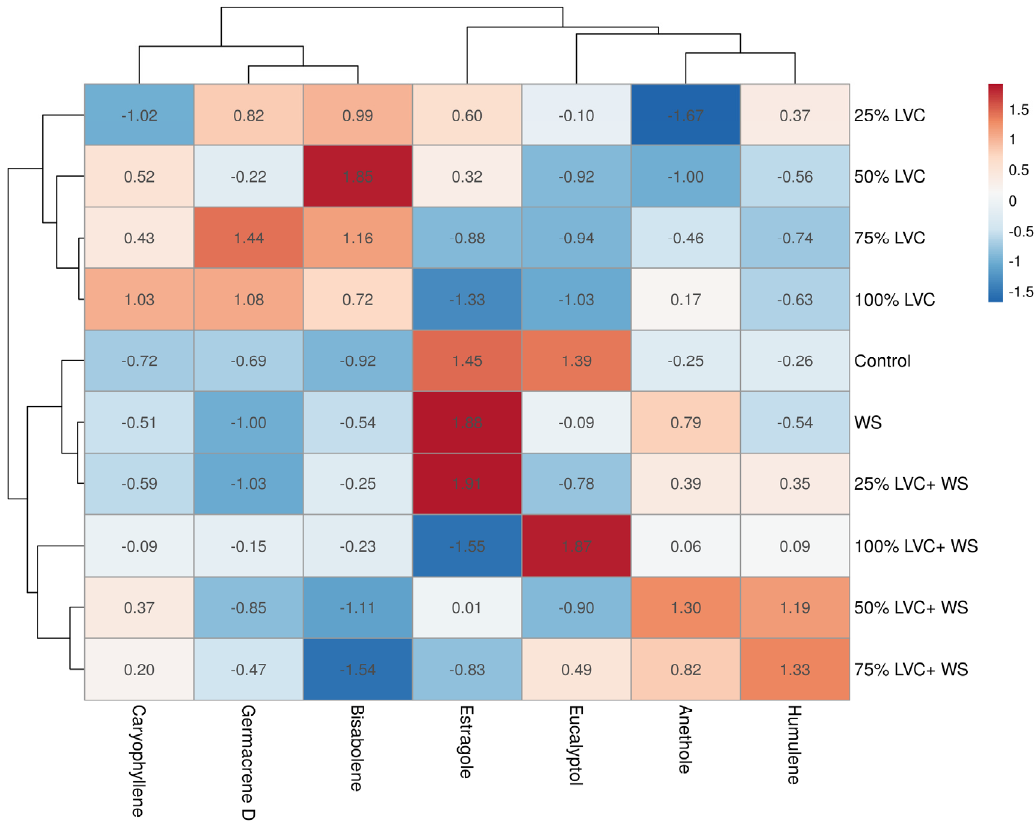
Figure 5. Heat map clustering of essential oil compounds corresponding to the treatments.